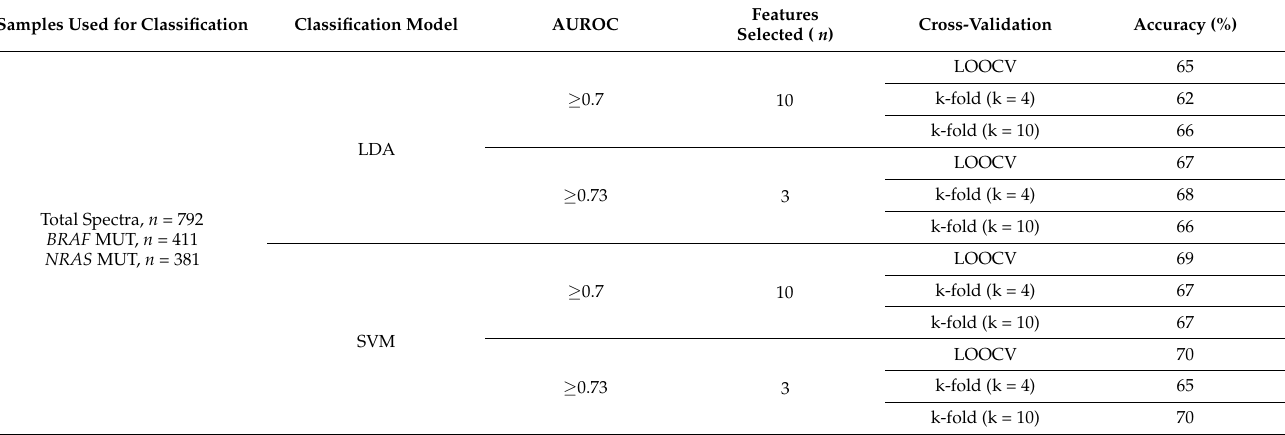
Table 5. Classification analysis to discriminate BRAF (v-raf murine sarcoma viral oncogene homolog B1) ( BRAF MUT) from NRAS (neuroblastoma RAS viral oncogene homolog) ( NRAS MUT)